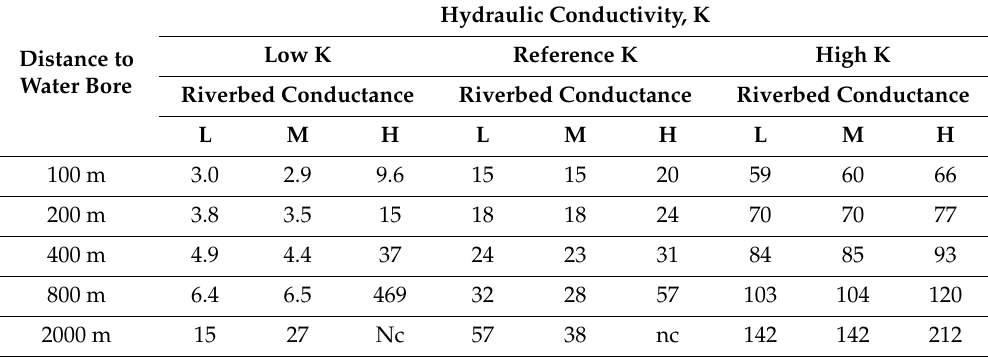
Table 1. Dilution factors in groundwater for di ff erent values of aquifer hydraulic conductivity ( K ) and riverbed conductance. Gradient was modified by changing riverbed conductance: L = low, M = medium, H = high. Dilution factors are identical for di ff erent porosities (0.1, 0.2, and 0.4). Results have been rounded to two significant numbers. nc = not calculated because solute plume bypasses the water bore at 2000